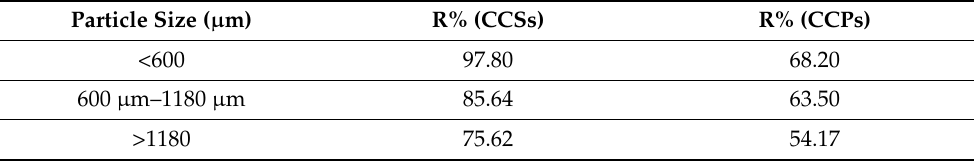
Table 2. Effect of adsorbent particle size on MB removal efficiency.